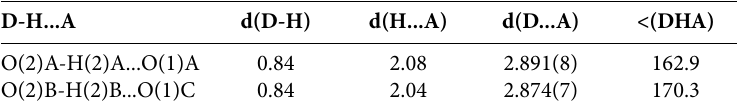
Table 3. Hydrogen Bond Lengths (Å)and Bond Angles (°) for the C6A-C10-OH D-H...A